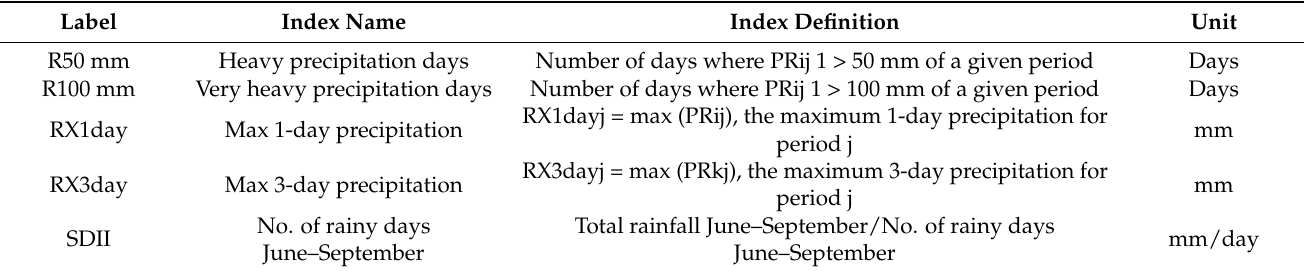
Table 3. Extreme climate indices used in